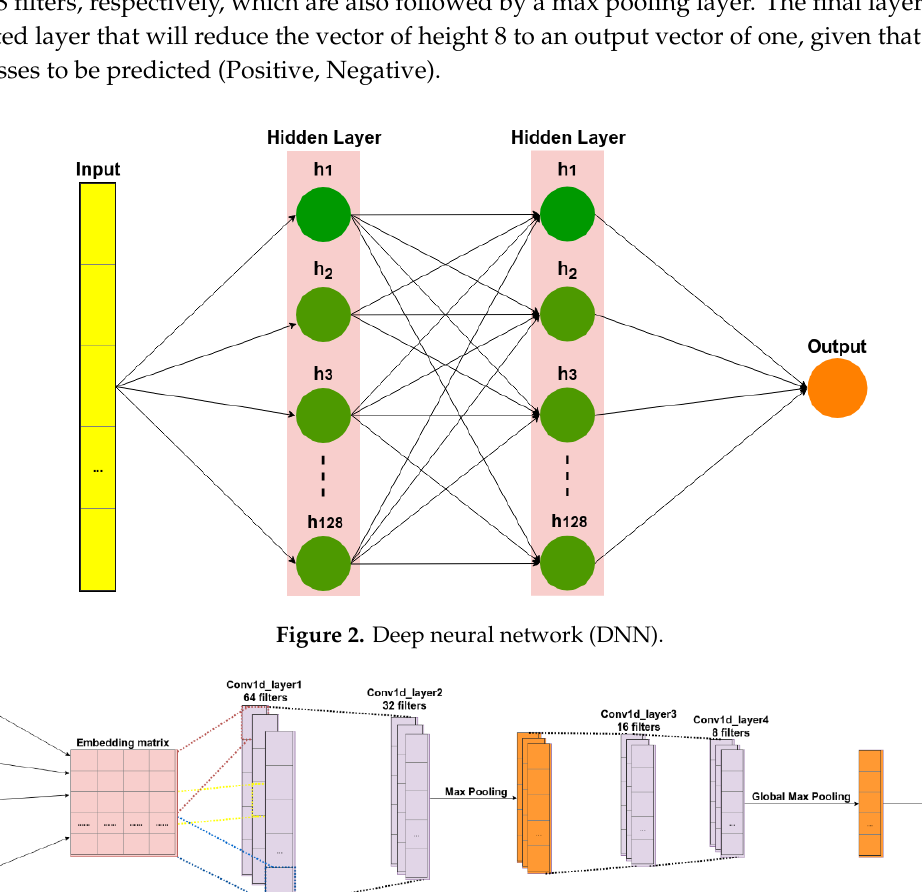
Figure 1. Differences between two classification approaches of sentiment polarity, machine learning (top), and deep learning (bottom). Part of Speech (POS); Named Entity Recognition (NER); Term Frequency-Inverse Document Frequency (TF-IDF).